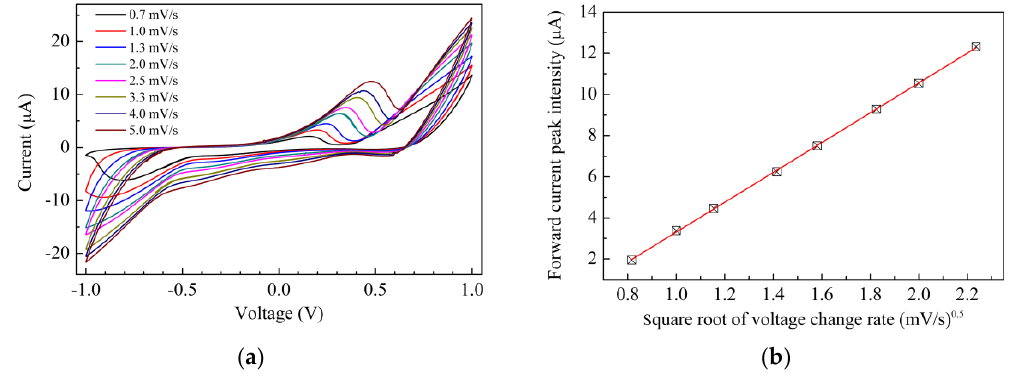
Figure 5. ( a ) Current-voltage loop of the Au/chitosan:CuOx/chitosan/Au cell, measured at different scan speeds; ( b ) Intensity of the forward current peak of Figure 5a, plotted against the square root of the scan speed.